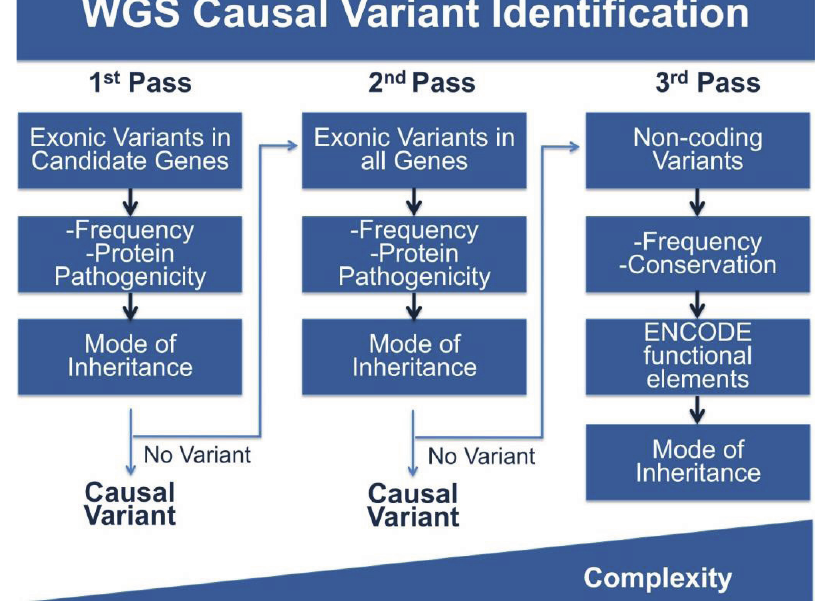
Figure 2. Pipeline for WGS Variant Identification. WGS produces ~4 million variants per genome and requires extensive filtering to identify variants of interest. Shown here is a potential pipeline to identify variants. The first pass of the pipeline entails only reviewing variants in the coding regions of genes of interest and filtering by frequency, protein pathogenicity, and mode of inheritance (segregation in available family members). If no variant is identified, a second pass includes the same filtering steps, but on variants in all coding regions. The third pass includes analysis of non-coding variation using frequency, conservation and ENCODE annotation, along with mode of inheritance. The complexity of analysis increases with each